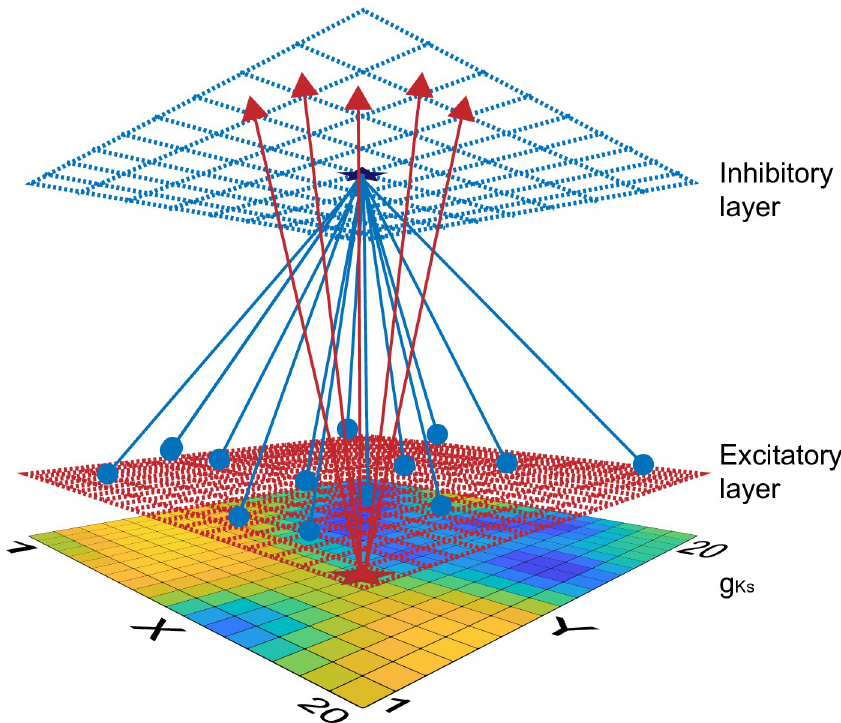
Fig 9. Schematic showing E—I network connectivity and spatially heterogeneous g distribution. Network K s consisted of 100 inhibitory neurons (blue top layer) and 400 excitatory neurons (red middle layer) evenly distributed over square lattices periodic boundary conditions. E-E and E-I synapses were short range (red arrows) while I-I and I-E synapses (blue arrows) were global. Bottom layer shows an example of a heterogeneous g spatial distribution K s mapping (yellow to blue indicates high to low g K s